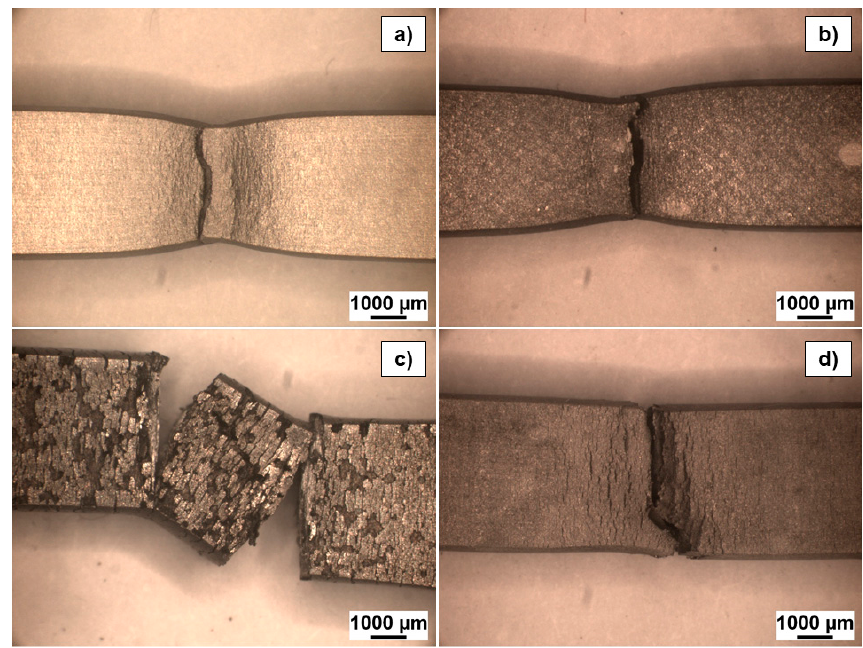
Figure 11. Macrograph acquired on the gauge length of DSS 2304 as-received ( a ) and aged at 850 °C for 5 ( b ), 10 ( c ) and 60 min ( d ) after SSRT in NACE TM-0177 in the presence of 10 − 3 M S 2 O 32 − .